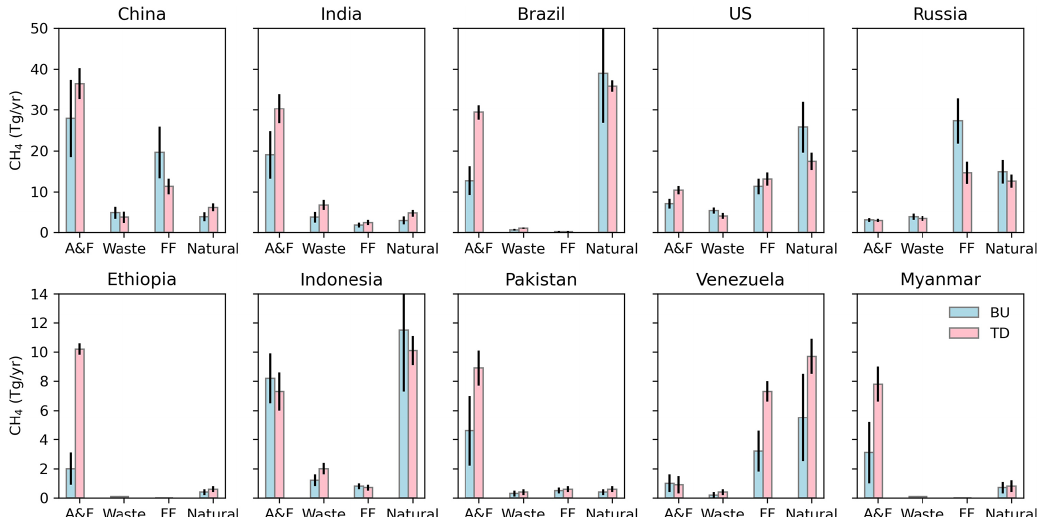
Figure 5. Emissions by sector for the top 10 emitters. AF represents agricultural and fires. FF represents fossil fuels or coal, oil, and gas. Natural represents wetlands, aquatic sources, and geological seeps. Bottom-up (BU) inventory estimates are shown as blue bars, and the remote sensing/top-down (TD) estimates are shown as pink bars. The uncertainties in both quantities are shown as black lines. Uncertainty calculations for bottom-up and top-down estimates are discussed in Sect.